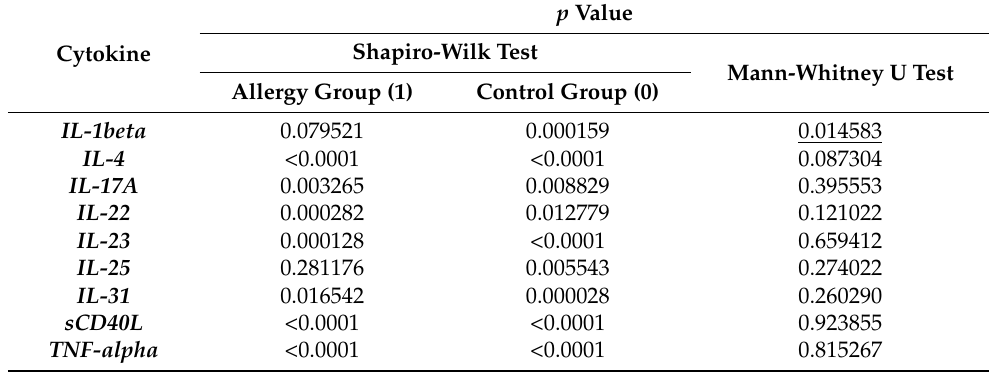
Table 3. The results of univariate statistical analysis of the serum cytokine concentrations of patients with IgE-mediated allergy (allergy group (1)), and participants without IgE-mediated allergy (control group